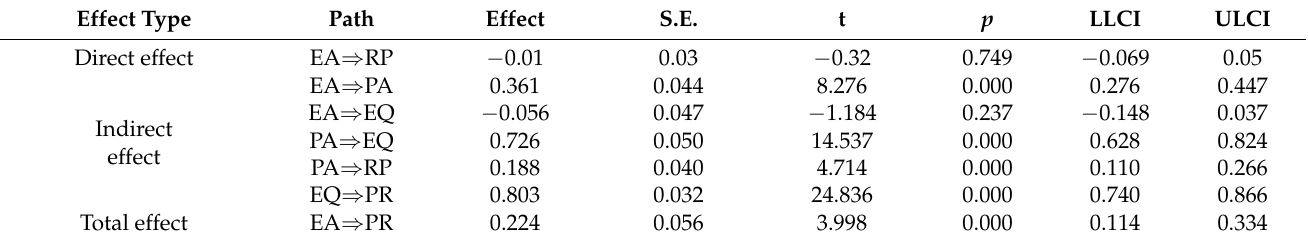
Table 11. Results of the effects the analysis process.